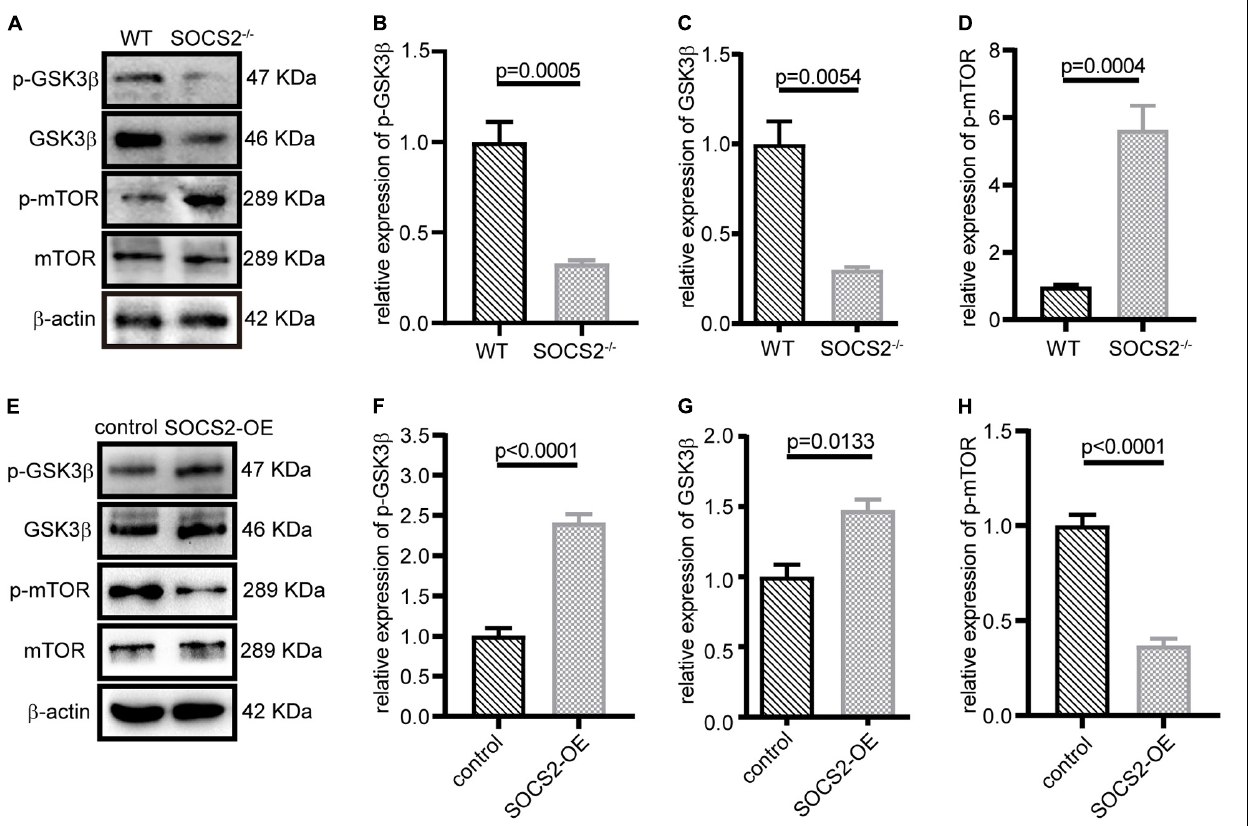
FIGURE 5 | SOCS2 regulated the phosphorylation of glycogen synthase kinase 3 β (GSK3 β ) and mTOR. (A) Western blot images of p-GSK3 β , GSK3 β , and p-mTOR were detected in the primary RPE from WT and SOCS2 − / − . (B,C,D) Data shown are the mean of GSK3 β , p-GSK3 β , and p-mTOR bands quantified by ImageJ software and normalized to β -actin. Values for the control were set to 1. (E) Phosphorylation of GSK3 β and mTOR was detected by immunoblot in ARPE-19 after transient transfection with SOCS2-OFP expression plasmids or OFP control vectors. (F,G,H) Data shown are the mean of p-GSK3 β , GSK3 β , and p-mTOR bands quantified by ImageJ software and normalized to β -actin. The two-tailed unpaired t -test was